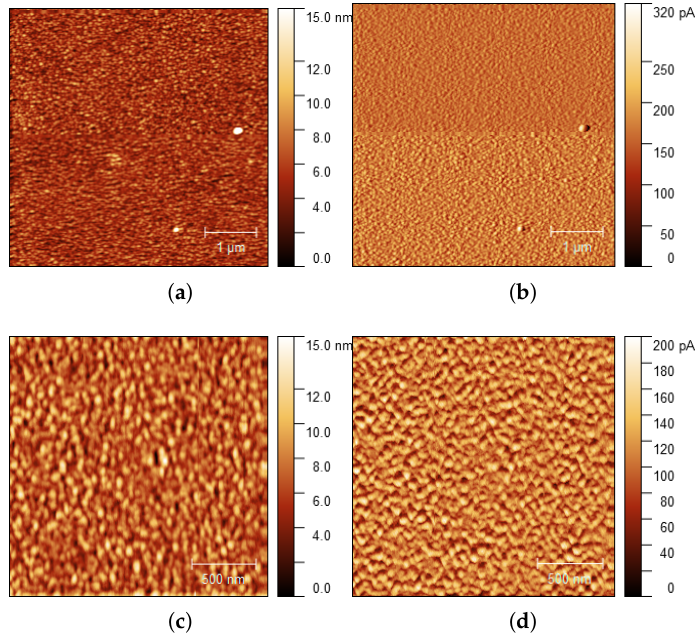
Figure A3. Topography of the 30 nm thickness Au film on glass imaged in AFM constant force mode ( a , c ) and error deflection mode ( b , d ). Average surface roughness R a = 1.12 nm ( a ), 18.88 pA ( b ), 1.53 nm ( c ) and 21.45 pA ( d ), scan size 5 × 5 µ m 2 ( a , b ) and 2 × 2 µ m 2 ( c , d